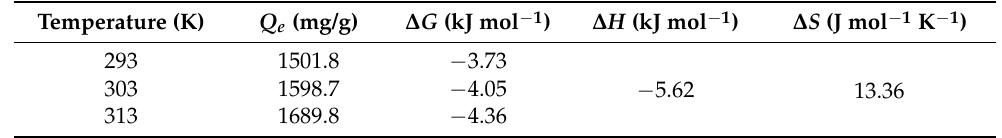
Table 4. Thermodynamic parameters for the adsorption of MG onto